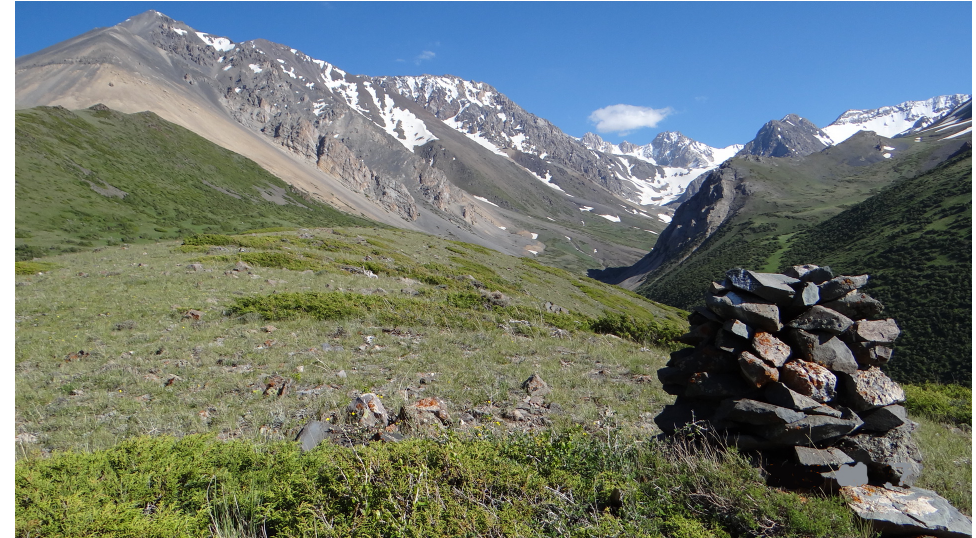
Figure 1: Aksu-Zhabagly NR of Kazakhstan in the Western